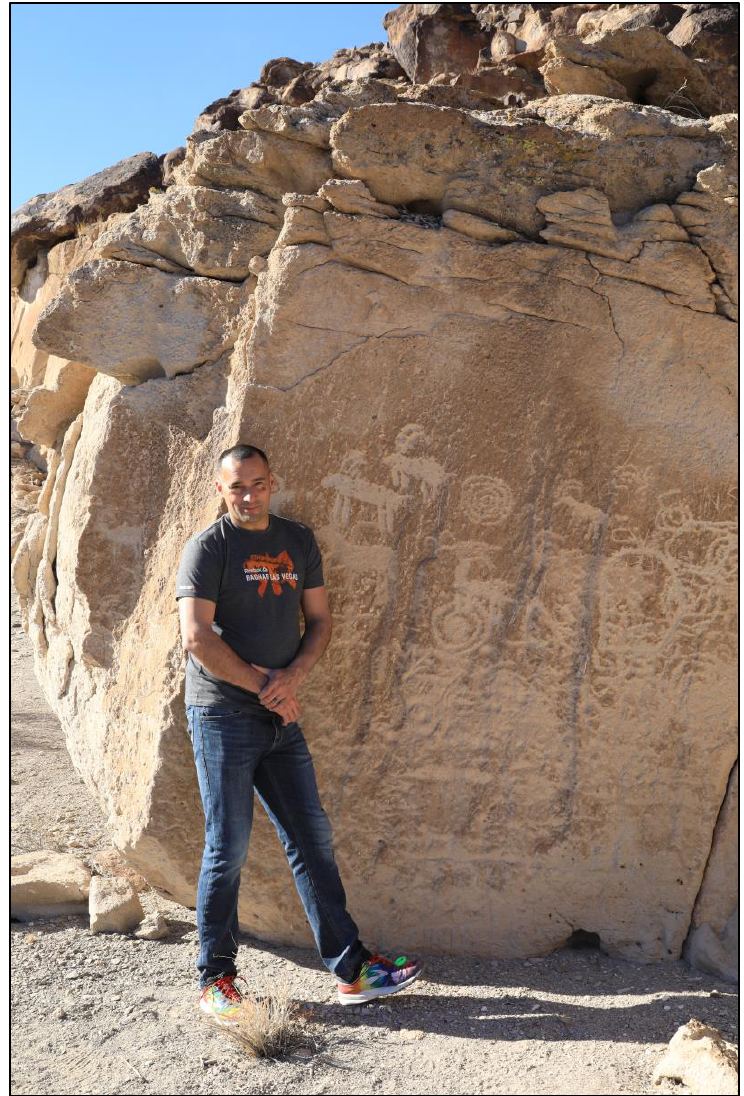
Figure 16. Representative interprets pecking panel in canyon (Source: Stoffle).